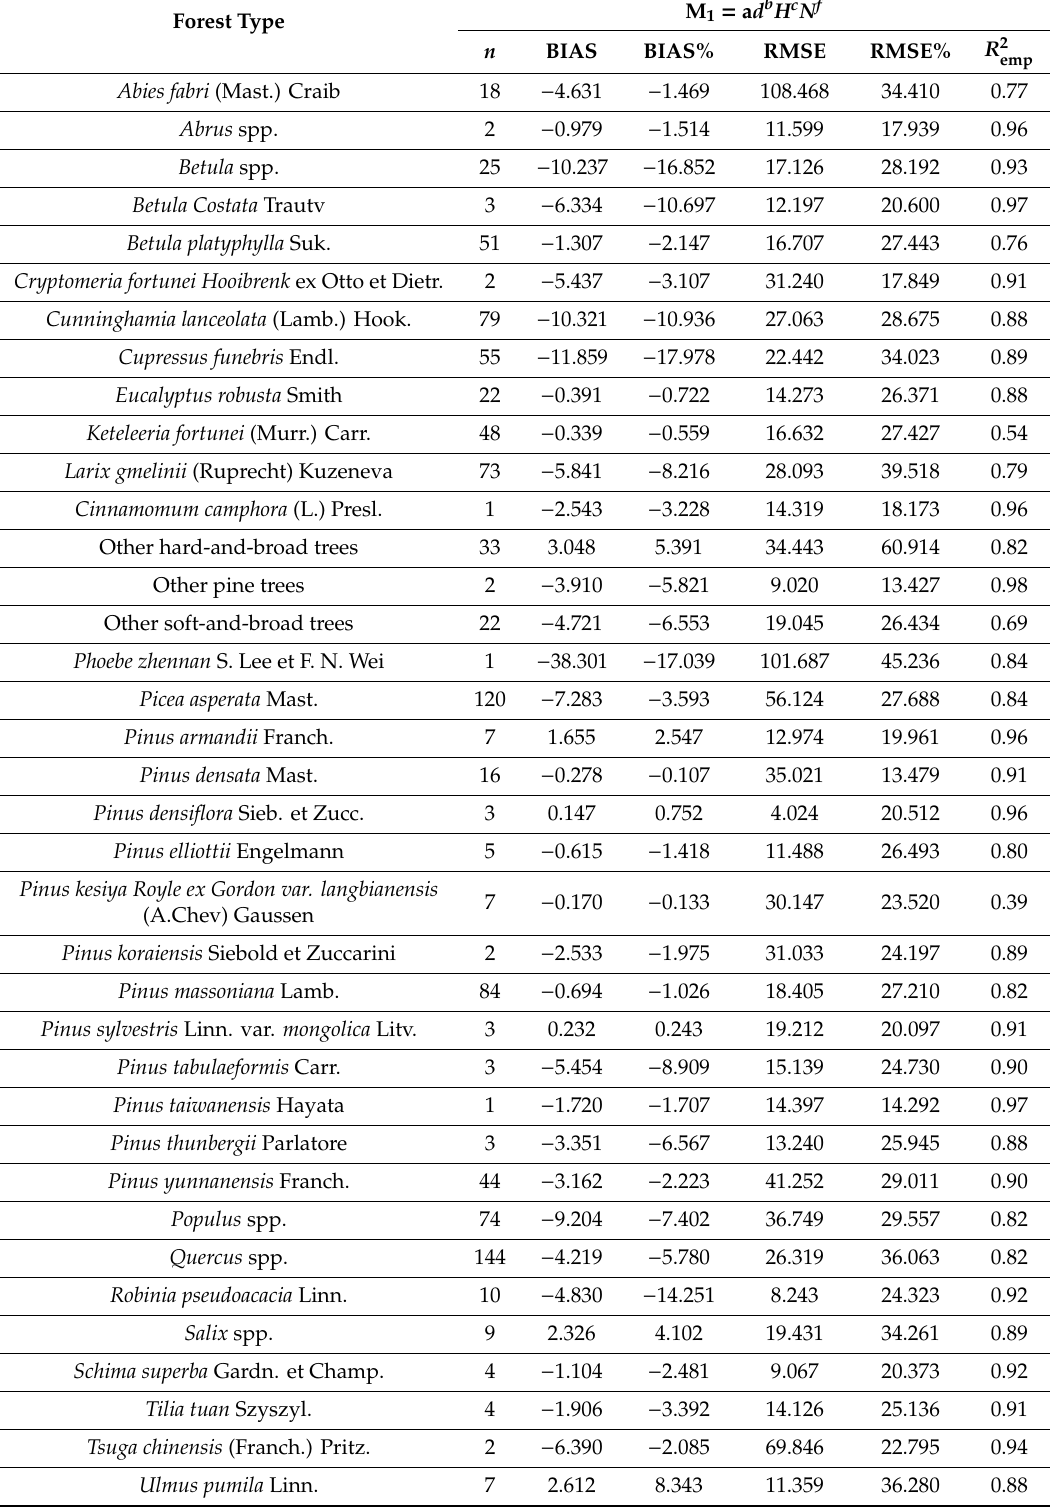
Table 6. Validation of the stand volume precision of model 1 for di ff erent forest types. Forest